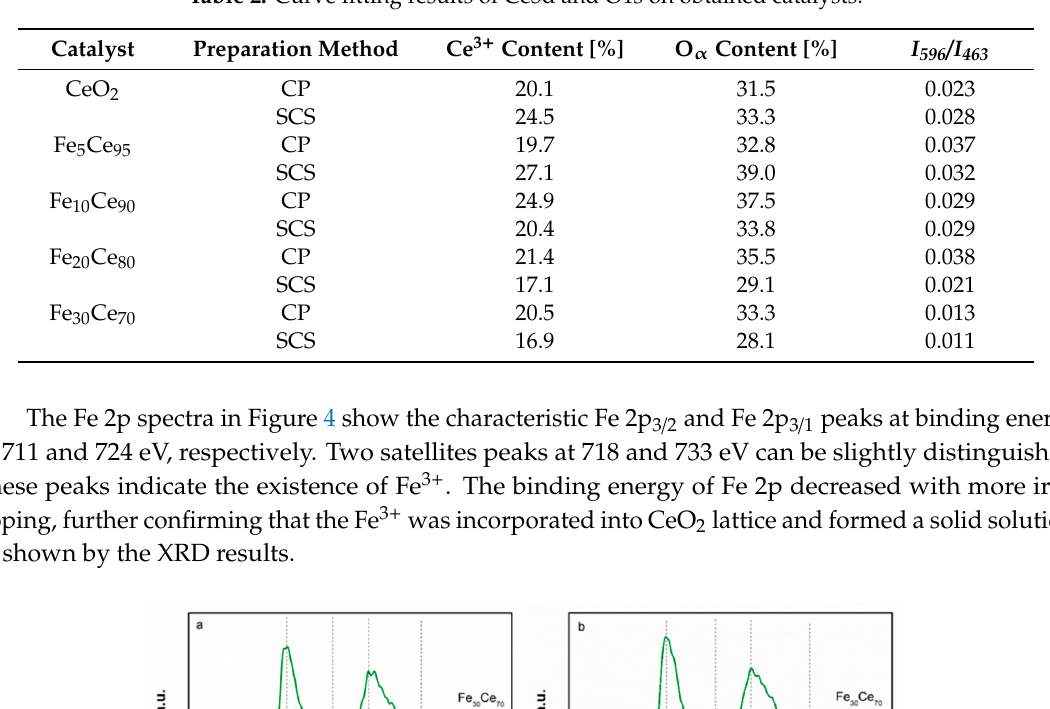
Figure 4. XPS spectra of Fe2p: ( a ) Co-precipitation method, ( b ) solution combustion synthesis method.